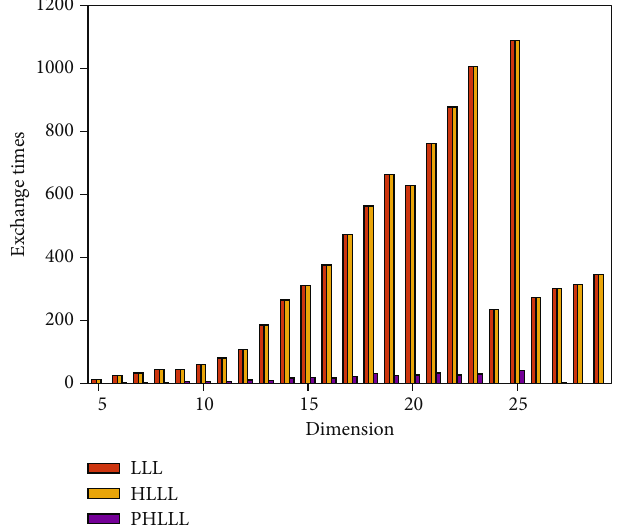
Figure 3: Comparison of basis vector exchange times of three